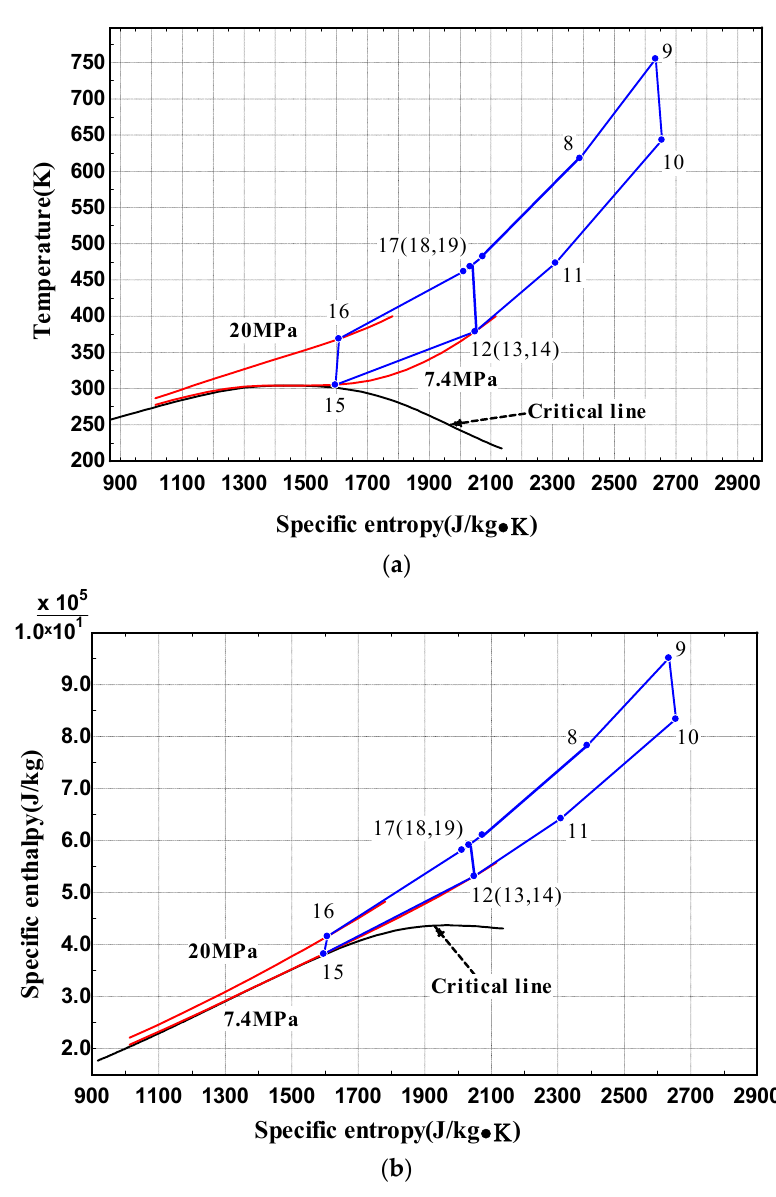
Figure 2. ( a ) T-S and ( b ) h-s diagram of the s-CO 2 recompression Brayton cycle.